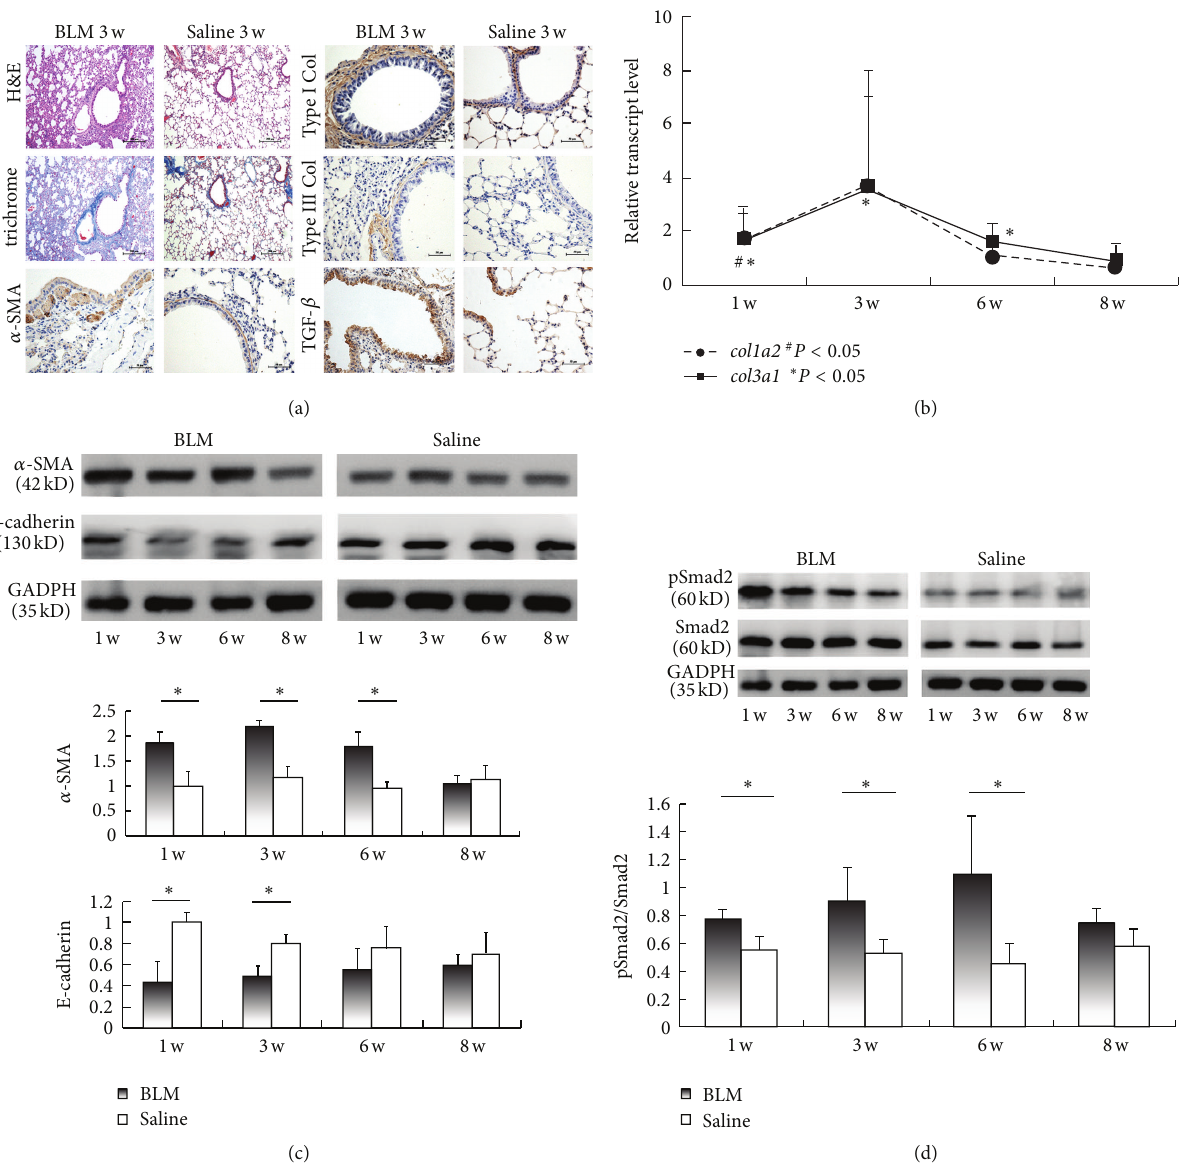
Figure 1: Bleomycin-treated mice undergo robust epithelial to mesenchymal transition (EMT). (a) Representative photomicrographs of lung sections were obtained from mice treated with bleomycin (BLM) or saline (week 3). Sections were stained with hematoxylin and eosin (H&E), and Masson’s trichrome, as well as by immunohistochemistry for anti- 𝛼 -smooth muscle actin( 𝛼 -SMA), anti-collagen I (Col I), anti-collagen III (Col III), anti-transforming growth factor (TGF)- 𝛽 antibody. Bars = 200 𝜇 m (for H&E and Masson’s trichrome staining), or 50 𝜇 m (for immunohistochemistry). (b) Expressions of col1a2 and col3a1 from the lung tissues of BLM-treated mice were measured by real-time reverse transcription-polymerase chain reaction (RT-PCR) analysis relative to that of saline-treated mice. # 𝑃 < 0.05 (for col1a2 ); ∗ 𝑃 < 0.05 (for col3a1 ). (c) Protein levels of 𝛼 -SMA, E-cadherin and GADPH in lung homogenates were determined by western blotting and analyzed by densitometry compared to GADPH expression. The same amounts of total protein are loaded in each lane. (d) Protein levels of phosphorylated Smad2 (pSmad2), total Smad2, and GADPH in lung homogenates were determined by western blotting and analyzed by densitometrycomparedtoGADPHexpression.Thesameamountsoftotalproteinareloadedineachlane.FoldincreaseinpSmad2expression after normalization to total Smad2 expression is shown. ∗ = 𝑃 < 0.05 ; ∗∗ = 𝑃 < 0.01 . Data presented in (b), (c), and (d) are representative of results from two independent experiments with five mice in each group. Values are shown as mean ±